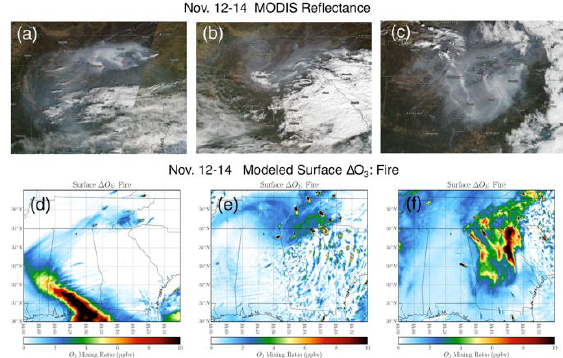
Figure 3. (a-c). MODIS true color reflectance in 2016 Nov 12-14 at 19UTC, respectively. (d-f) Spatial distribution of fire-impacted surface